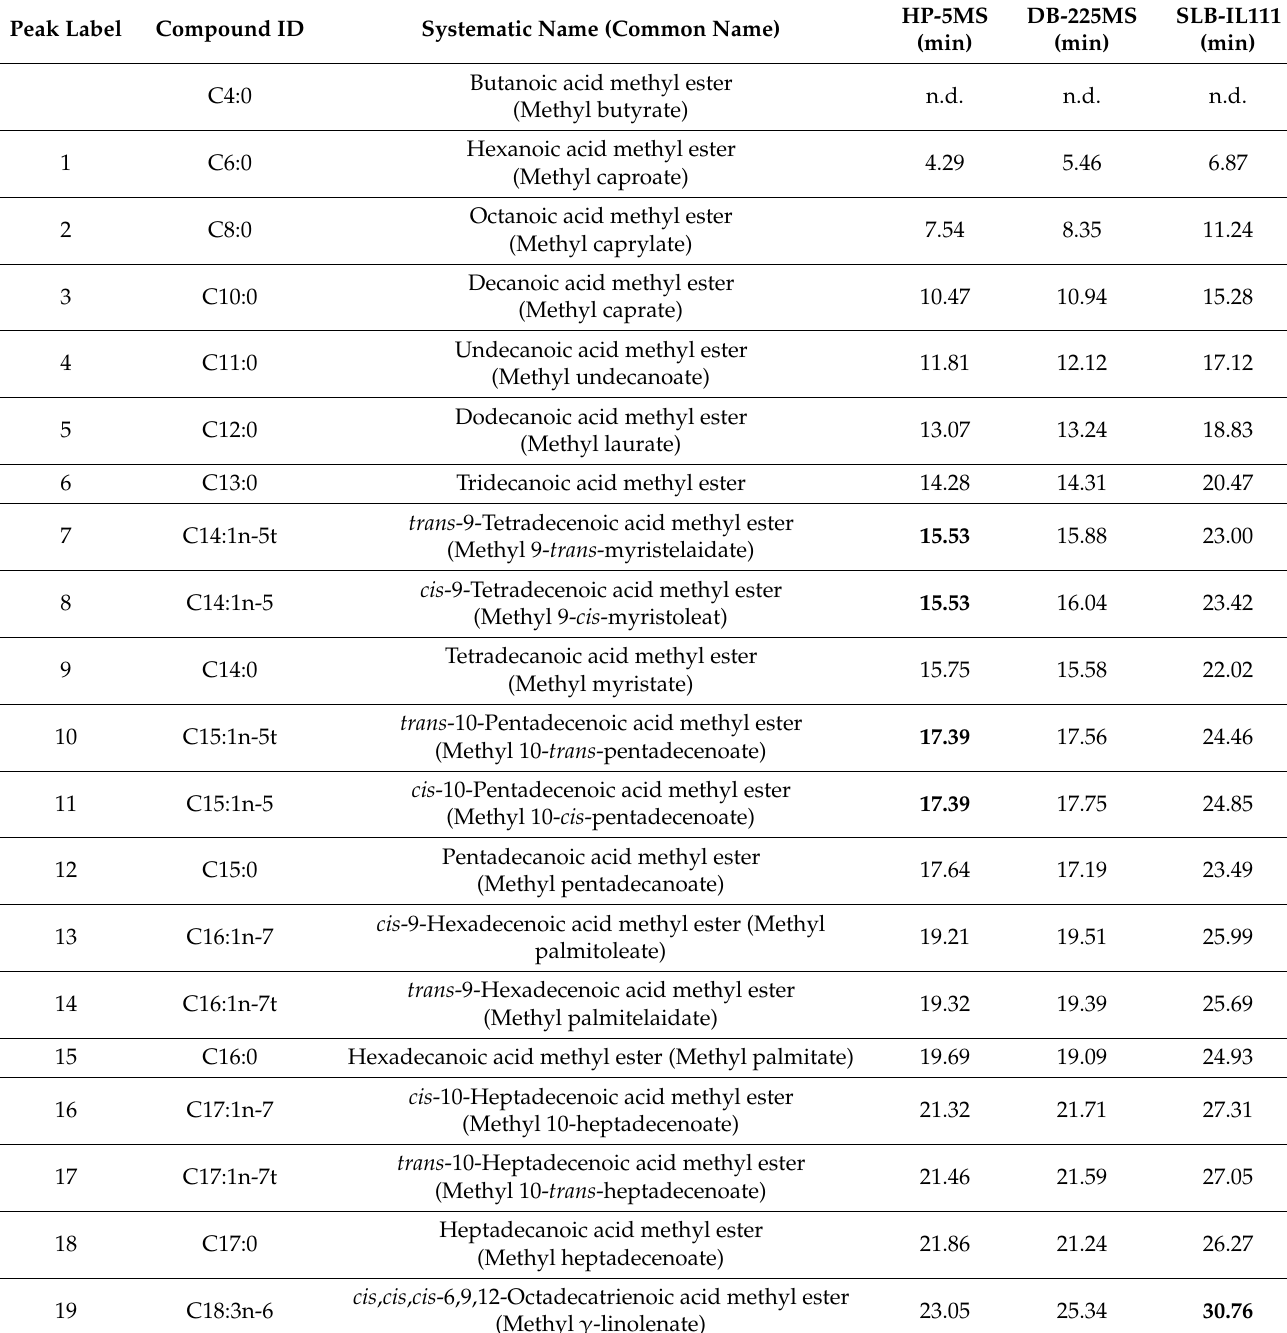
Table 1. Retention time values of fatty acid methyl ester components in the GLC-674 mixture using the optimized separation methods for the three GC columns. The optimized experimental conditions are detailed in Materials and Methods. Peak